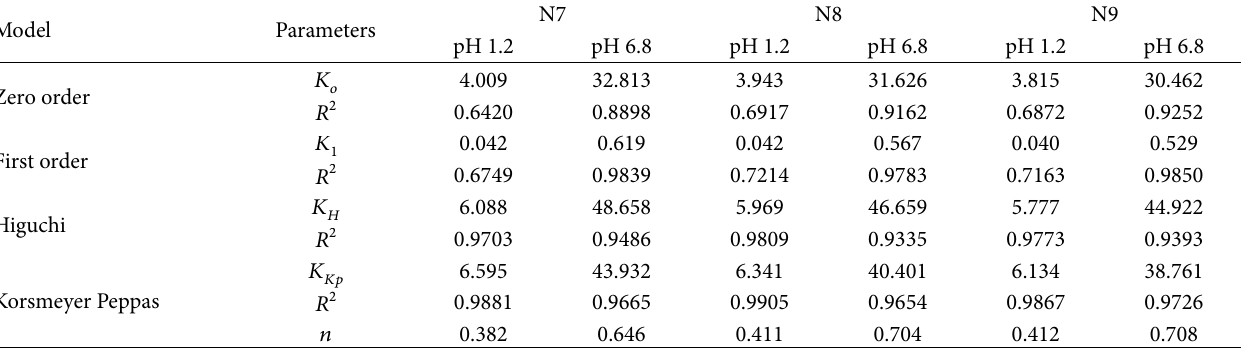
Table 6: Models of in-vitro drug release kinetics of PEG-g-poly (MAA) nanogels formulations with varying concentration of